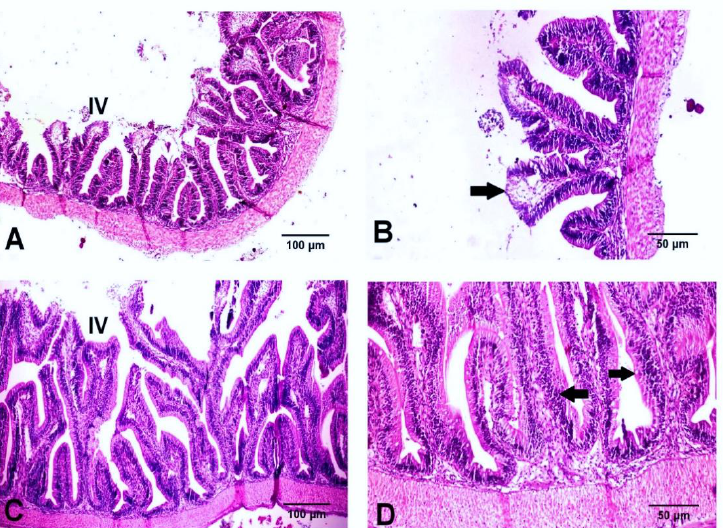
Figure 7. Histological examination of the intestines of the control and Hilyses-treated groups. ( A ). Control group showing intestinal villi (IV) (H&E ×100); ( B ). Higher magnification of the previous picture showing sloughing and necrosis of some enterocytes (arrow) (H&E ×200); ( C ). Hilyses-treated group showing intact intestinal villi (IV) (H&E ×100); ( D ). Hilyses-treated group showing an intestine with severe hyperplasia of enterocytes (arrow) (H&E ×200).